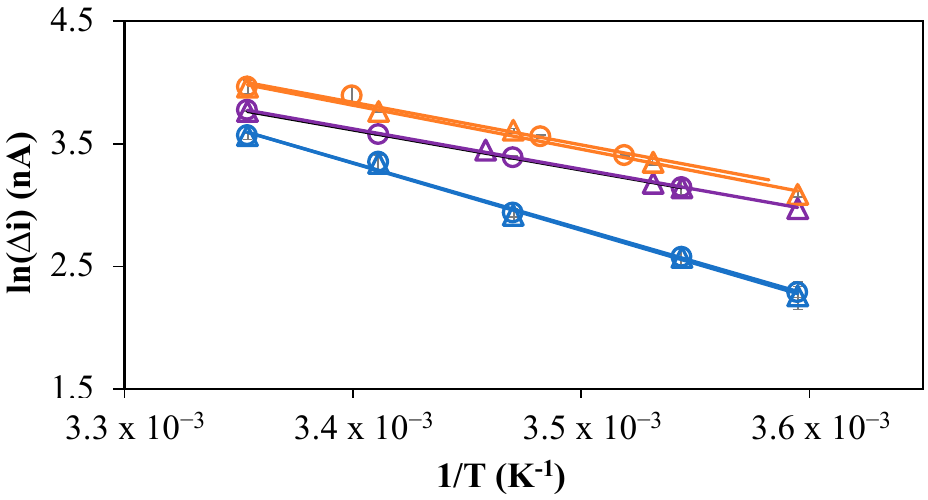
Figure 6. Experimental temperature effect on the Ni(II) peak current intensity in synthetic water (violet), freshwater (orange) and sea water (blue). Each experiment was done from 25 °C down to 5 °C (open circles) and from 5 °C up to 25 °C (open triangles) in triplicate. As expected from the theory, a linear response was observed between ln(i) and 1/T in the three different media of interest (Figure 6). The correction temperature effect factors, G/R expressed in K, for Ni(II) were found to be − 3223 229, 3567 143 and 4178 364 in the synthetic media, freshwater and seawater, respectively. The fact that the correction factors in synthetic media and freshwater are comparable indicates that the interactions influencing the measurements are similar in both media. The higher slope in seawater, a more complex medium, suggests that either the same kinetic limiting factor as in the two other media is more affected by the temperature or that another kinetic limiting factor arises from interactions with chloride or other components. The second hypothesis seems more likely. It may be concluded that the peak current behaves as a not entirely reversible system under the fast Ad ‐ SWCSV scan rate conditions used here (0.8 V s − 1 ). 2.4. Evaluation and Validation of the Analytical Method To ensure the reliability of the field monitoring data, freshwater and seawater sam ‐ ples were collected, respectively, in La Leyre River and the Arcachon Bay (South ‐ West France), filtered under 0.2 μ m and stored in 1 L polyethylene bottle. A first aliquot of the sam ‐ ples was used for Hg ‐ GIME Ad ‐ SWCSV direct dynamic Ni ‐ nioxime quantification (Ni Dyn ). A second aliquot of the samples was acidified at pH 1. A first subaliquot of the pH 1 sample was analyzed by ICP ‐ MS to quantify the total dissolved Ni concentration (Ni 0.2 ), while a second subaliquot was used to assess the Ni 0.2 measured by Hg ‐ GIME Ad ‐ SWCSV after UV irradia ‐ tion to decompose the organic matter. After UV irradiation, the pH was adjusted to 8.5 for the freshwater sample and 8.1 for the seawater sample. The Hg ‐ GIME Ad ‐ SWCSV measurements were performed after overnight sample re ‐ equilibration to assess the total dissolved Ni con ‐ centrations. The results obtained by ICP ‐ MS and Hg ‐ GIME Ad ‐ SWCSV were then compared. Ni 0.2 measured by ICP ‐ MS in both samples were comparable, within analytical errors, to the ones measured by Hg ‐ GIME Ad ‐ SWCSV after UV irradiation (Table 2), which val ‐ idates our analytical methodology. Ni Dyn determined in the raw samples by Hg ‐ GIME Ad ‐ SWCSV were lower than Ni 0.2 measured after UV irradiation. The results confirmed that our sensor only detects a small fraction of the total dissolved Ni(II) concentration. They also suggest a low competition of nioxime with nondynamic natural organic and inor ‐ ganic Ni sorbents. Ni Dyn represented 27% and 13% of Ni 0.2 measured by ICP ‐ MS (Table 2).